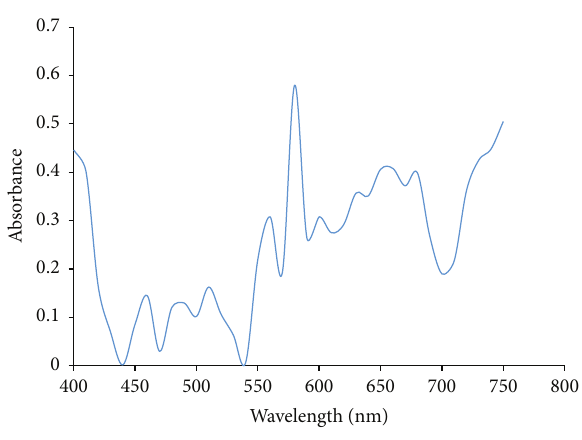
Figure 3: Hibiscus distilled water extract.